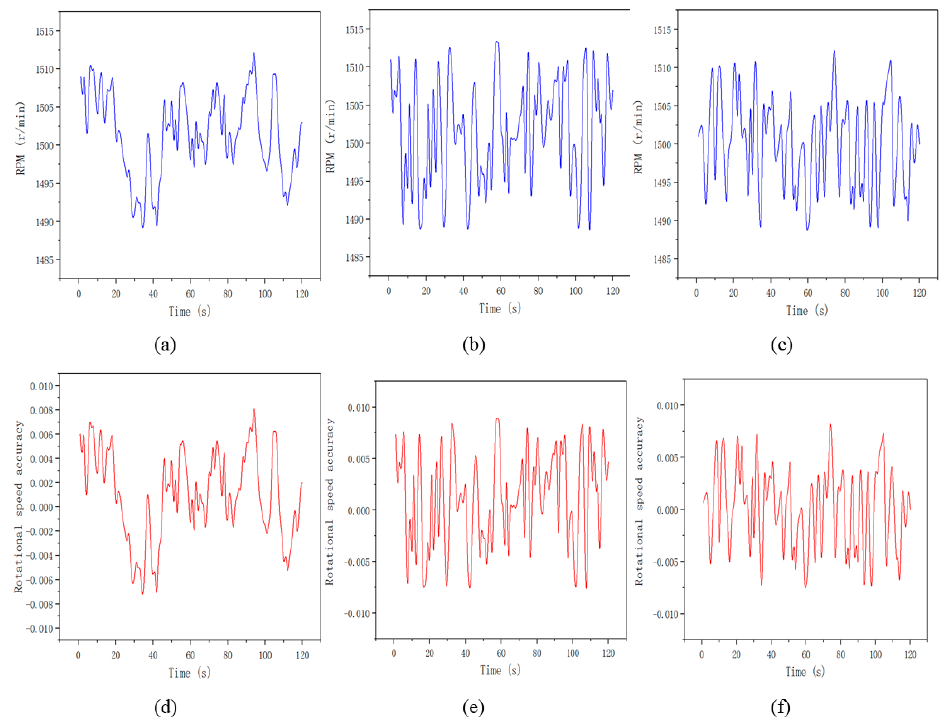
Figure 14. Motor speed under different working conditions. ( a ), ( b ) and ( c ) show the motor speed at 0.1 m/s, 0.3 m/s and 0.5 m/s, respectively; ( d ), ( e ) and ( f ) show the steady-state accuracy of motor speed at 0.1 m/s, 0.3 m/s and 0.5 m/s, respectively.